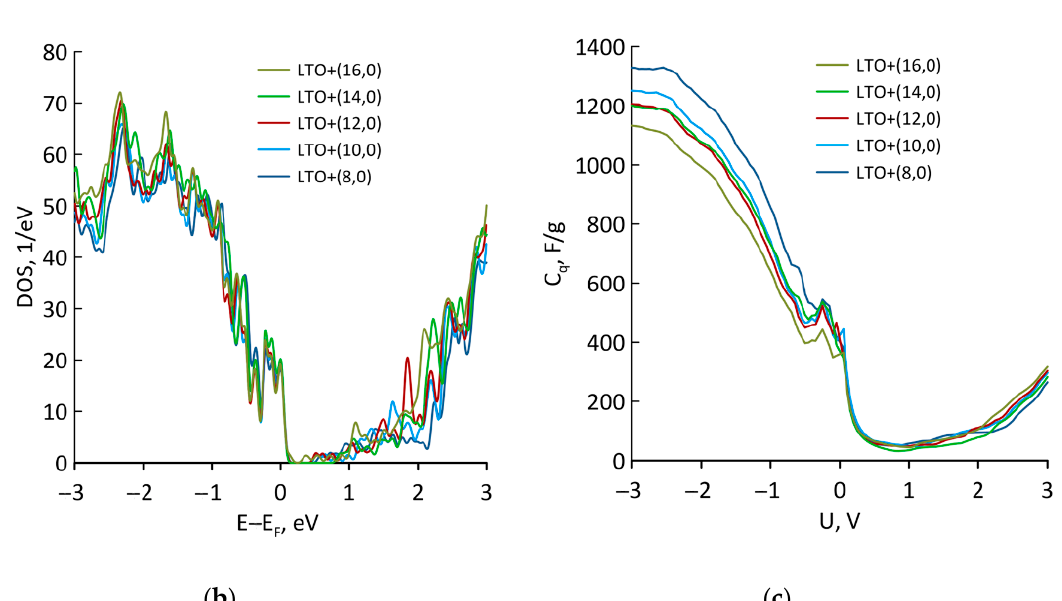
Figure 4. CNT/LTO nanocomposites: ( a ) atomic supercells of CNT(8,0)/LTO, CNT(12,0)/LTO,